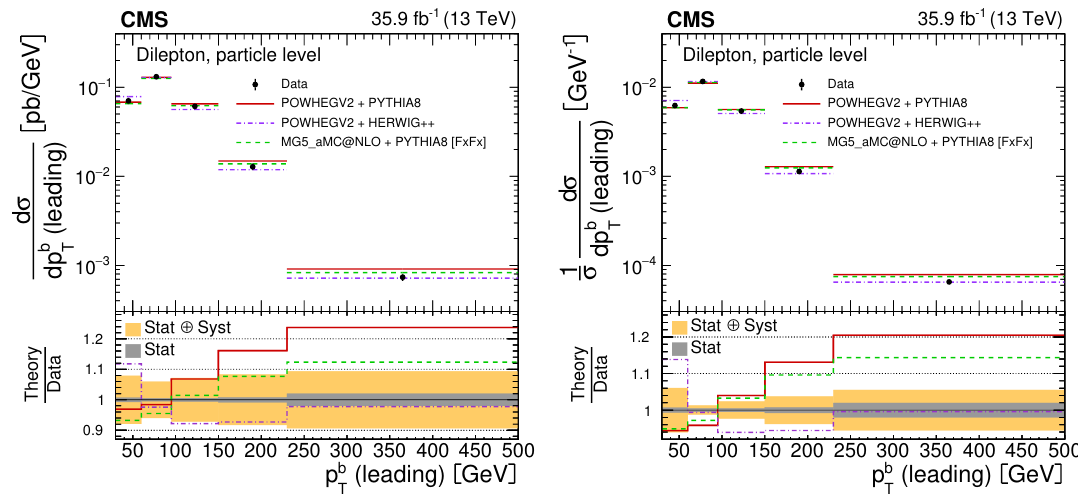
Figure 45 . The di(cid:11)erential tt production cross sections as a function of p b phase space at the particle level are shown for the data (points) and the MC predictions (lines). The vertical lines on the points indicate the total uncertainty in the data. The left and right plots correspond to absolute and normalised measurements, respectively. The lower panel in each plot shows the ratios of the theoretical predictions to the data. The dark and light bands show the relative statistical and total uncertainties in the data, respectively.